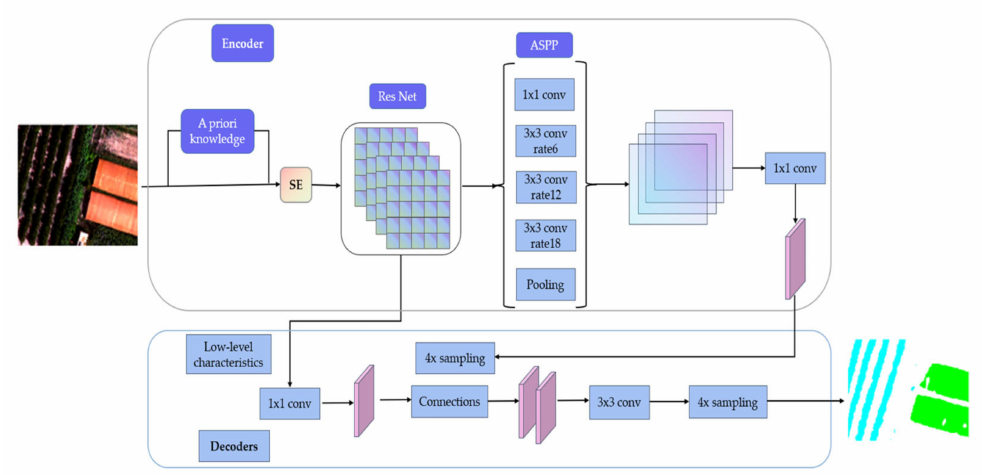
Figure 4. Improved DeepLabV3+ network structure.